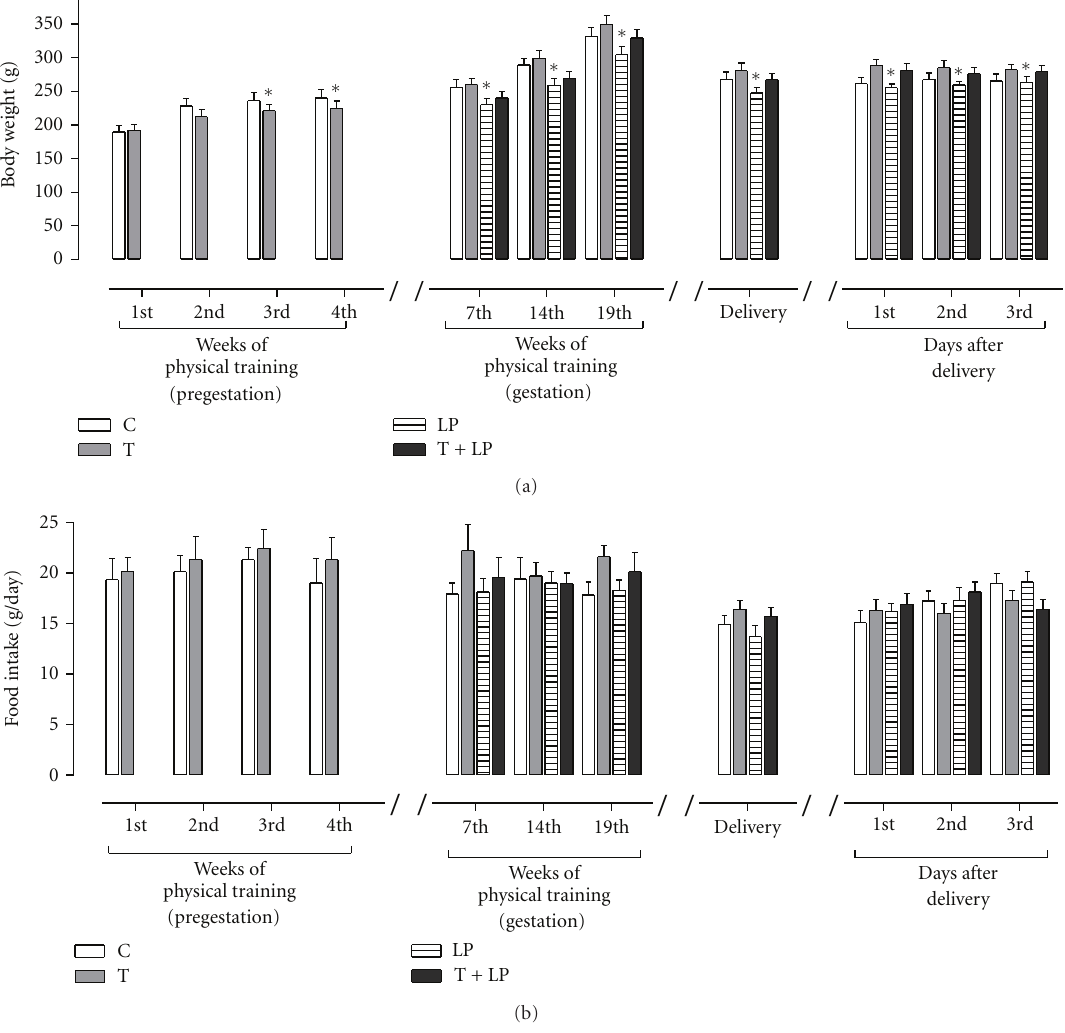
Figure 1: Body weight (a) and food intake (b) during pregestation and gestation by control (C, n = 5), trained (T, n = 5), low-protein diet (LP, n = 5), and trained + low protein dams (T + LP, n = 5). The protocol of physical training was initiated four weeks before pregnancy (5 days per week, and 60 minutes per day). During gestation, duration and intensity of each session of physical exercise were progressively reduced and each group received either 17% casein diet (C and T) or 8% casein (low-protein group, LP and LP + T) isocaloric diet ad libitum . The values are presented as means ± S.E.M. ∗ P < 0.05 versus C group using two-way ANOVA and Bonferroni’s post-hoc